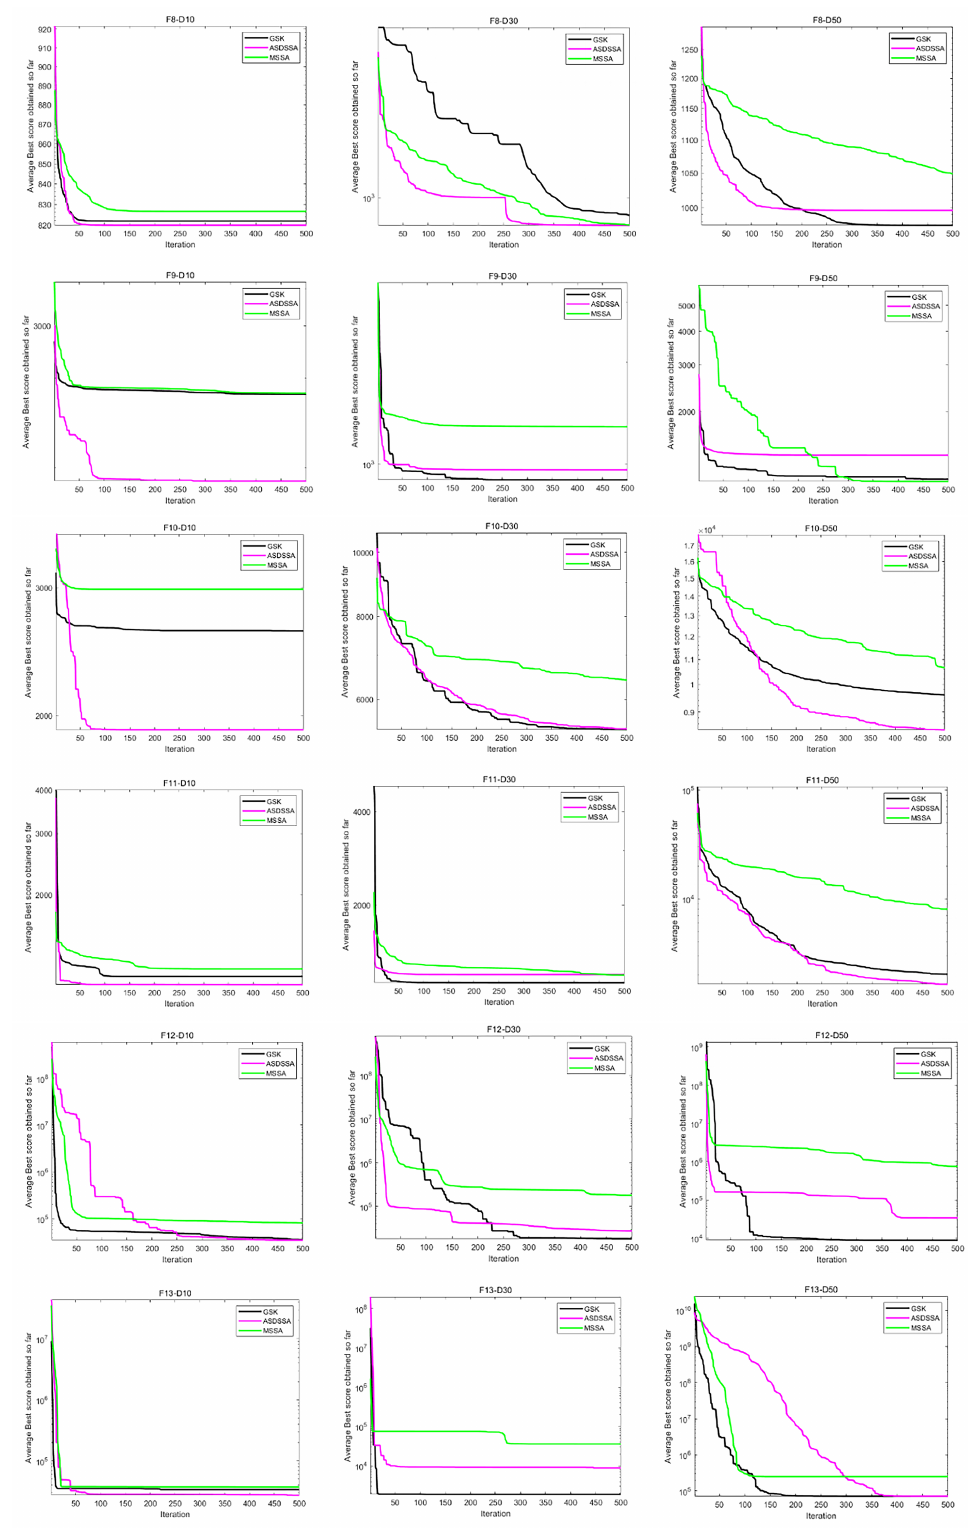
Figure 6. Convergence curves of